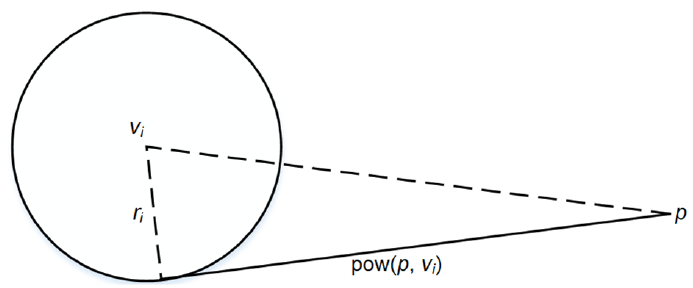
where d ( · ) means the spherical great circle, pow( p , v i ) is a geodesic distance between p and tangent point, intersection of a line through p tangent to circle and the circle, as shown in Figure 2. Figure 2.